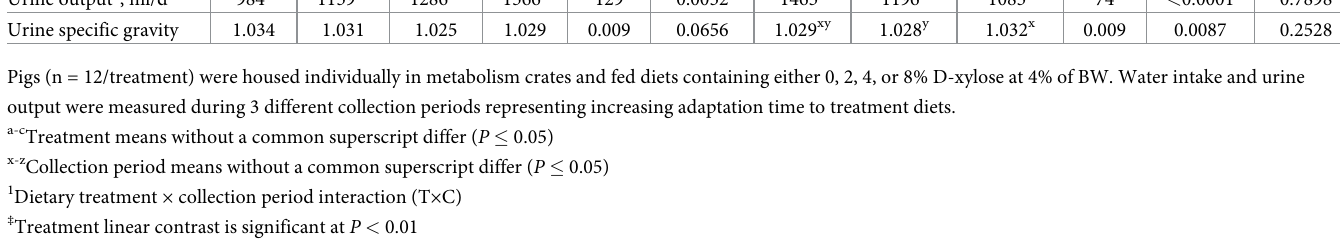
Urine N (%) decreased linearly with increasing dietary xylose concentration (Trt P = 0.009, linear P = 0.009; Table 5) but increased across collection periods as pigs had longer adaptation time to the diets (Col P < 0.0001). There tended to be an interaction between treatment and collection period for urine N with concentrations increasing across collection periods for all